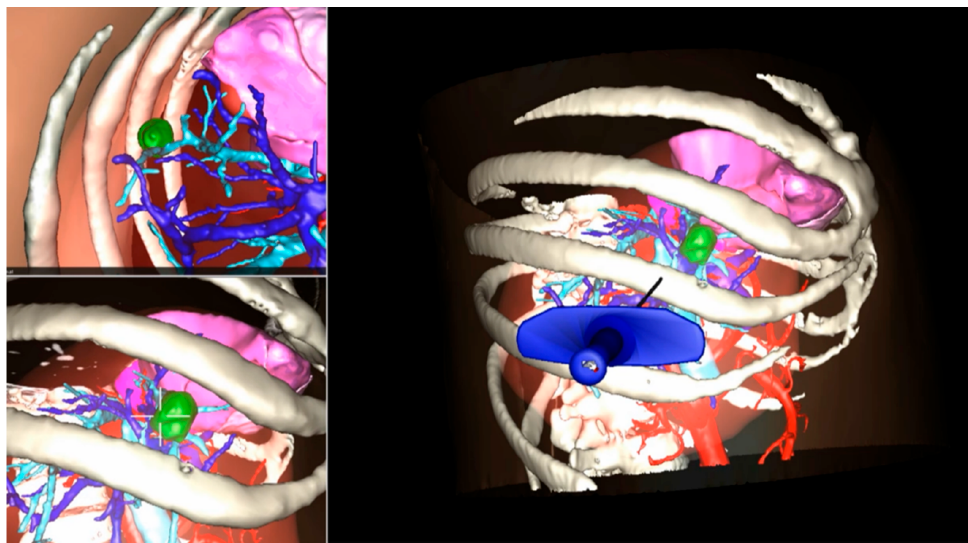
Figure 3. Use of Augmented Reality in planning needle placement during a percutaneous Radiofrequency liver ablation.